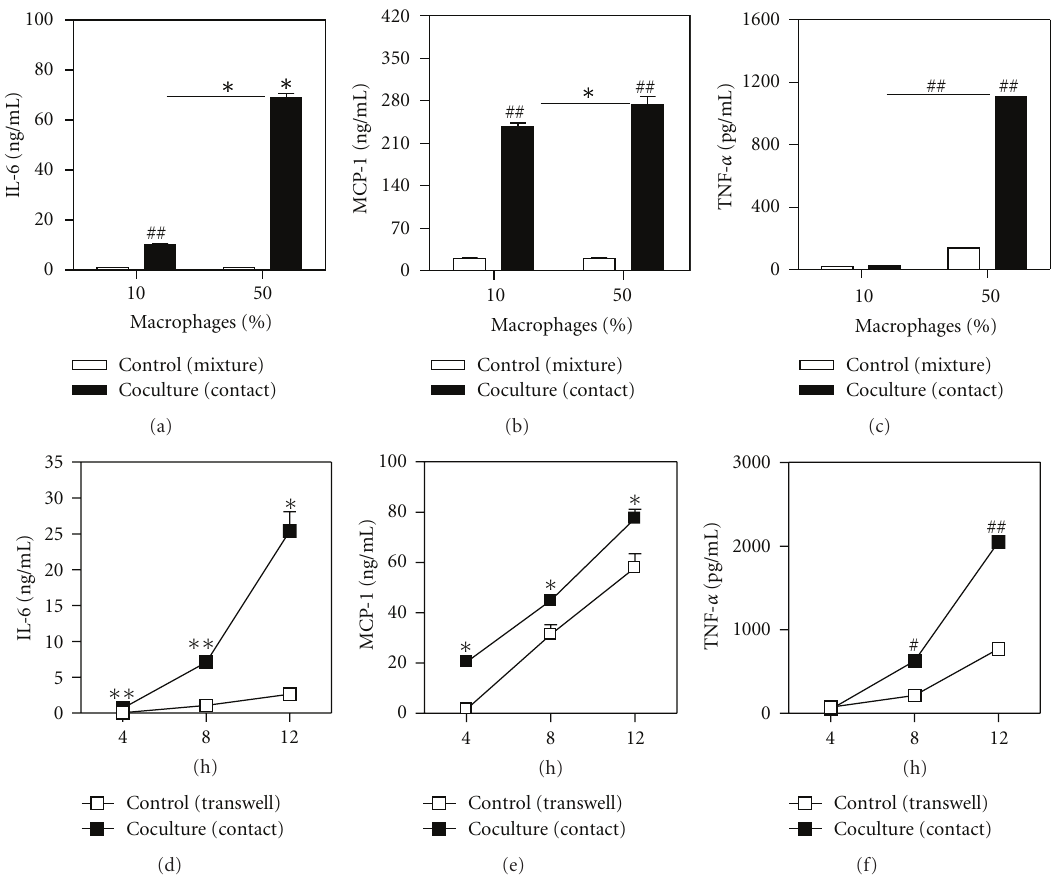
Figure 3: Release of inflammatory cytokines is enhanced in cocultures of 3T3-L1 adipocytes and Raw264.7 macrophages. Release of cytokines (IL-6, MCP-1, and TNF- α ) from 3T3-L1 adipocytes cocultured with Raw264.7 macrophages (10% or 50%) for 24 h (a–c). Control indicates mixed adipocytes/macrophages, which were cultured separately for 24h and mixed after harvest. Release of cytokines (IL-6, MCP- 1, and TNF- α ) from the contact coculture with 50% Raw264.7 macrophages or transwell system for indicated times (4h, 8h, and 12h) (d–f). Cell-free supernatants were collected, and concentrations of these inflammatory cytokines were determined by ELISA. Data are the mean ± SEM of three independent experiments performed in duplicate. ∗ P < 0 . 05; ∗∗ P < 0 . 01; # P < 0 . 005; ## P < 0 . 001 (compared with